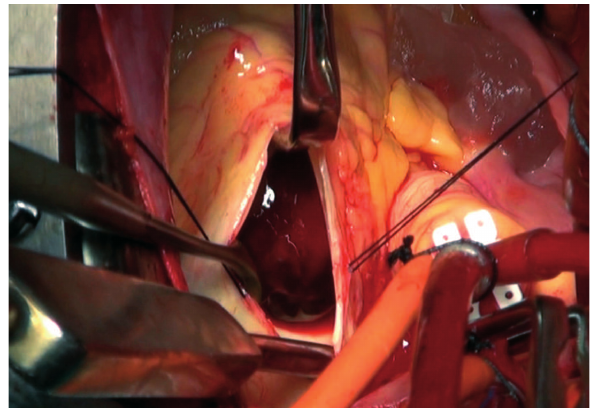
Fig. 2 – Figure showing widely opened main pulmonary artery with right ventricular myxoma prolapsing across the pulmonary valve into it (Picture is taken from the head end of the